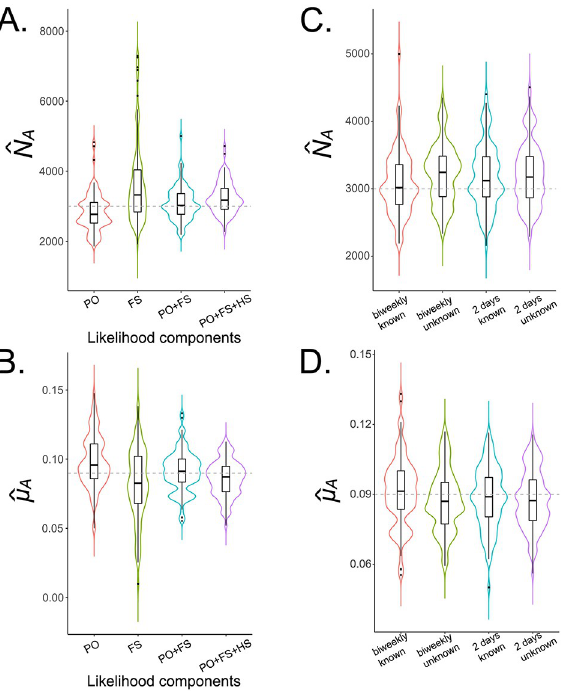
Fig 6. Pseudo-likelihood components to estimate N A and μ A for Ae. aegypti . Violin plots depict estimates of N A (A) (B) for the optimal sampling scheme determined in Fig 4 (1,000 adult females collected biweekly over a three and μ A month period, i.e., ca. 40 adult females per collection) and various included pseudo-likelihood components. The simulated population consists of 3,000 adult Ae. aegypti with bionomic parameters listed in Table 1. Boxes depict median and interquartile ranges of 100 simulation-and-analysis replicates for each scenario, thin lines represent 5% and 95% quantiles, points represent outliers, and kernel density plots are superimposed. Adult parameter estimates inferred from combined parent-offspring and full-sibling pseudo-likelihood components are more accurate than those inferred from either pseudo-likelihood component in isolation and more accurate than those inferred by inclusion of half-sibling pairs. In panels (C-D) , parent-offspring and full-sibling pseudo-likelihood components are used and cases of biweekly sampling and sampling every two days are compared, both where the sampling day is known and where the sampling day is only known within the interval between samples.